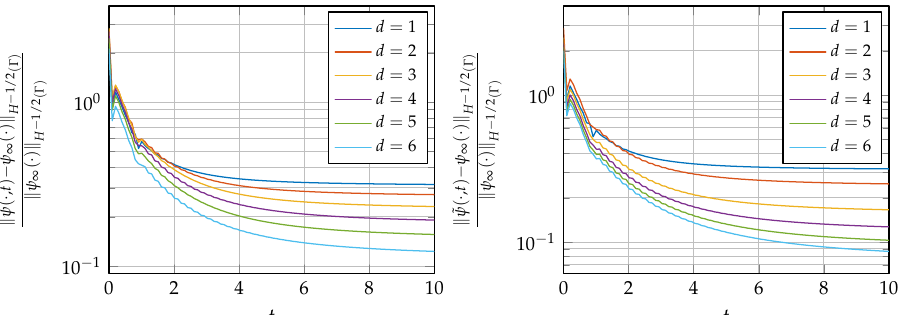
Figure 2. Relative error decay at T = 10 in H − 1 2 ( Γ ) norm.